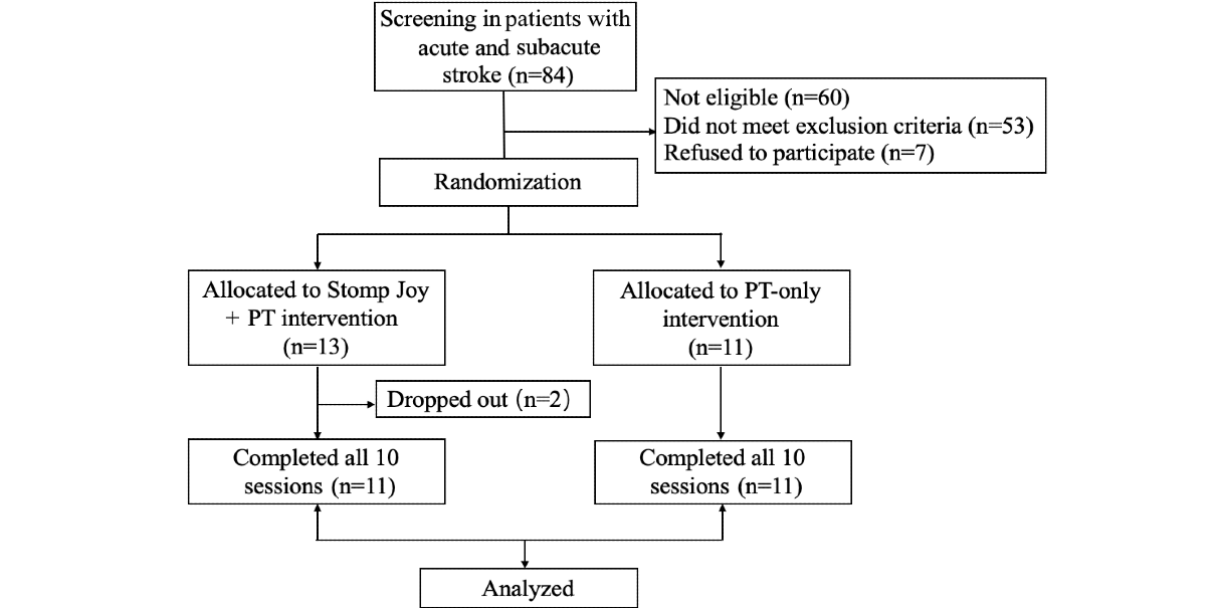
Figure 3. Flowchart of the study. PT: physical